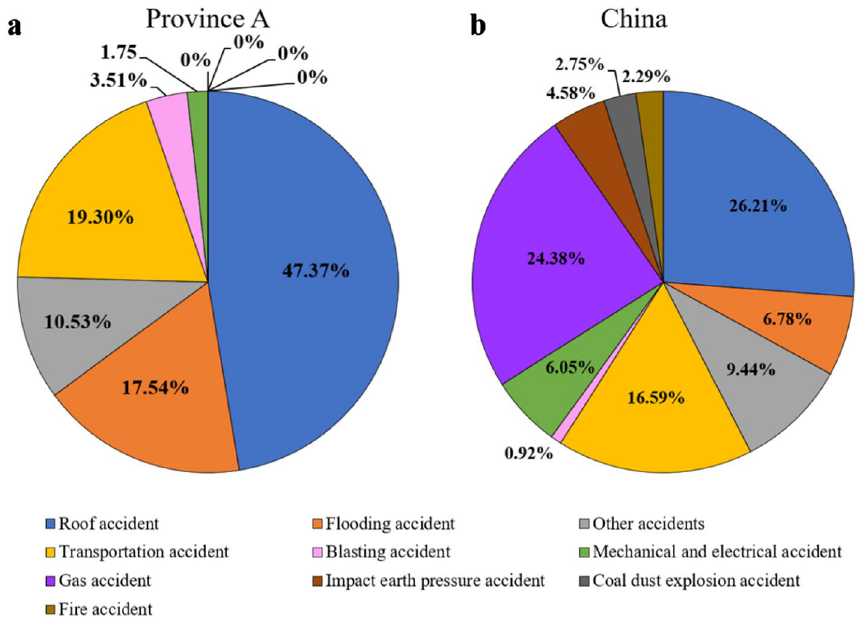
Figure 2. Comparison of the Mortality by type of accident in coal mines between China and Province A